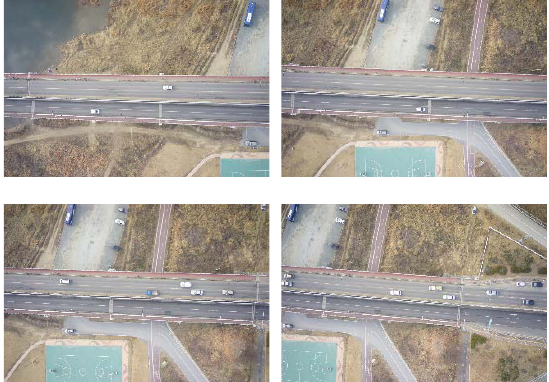
Figure 2. A few images from the UAV dataset